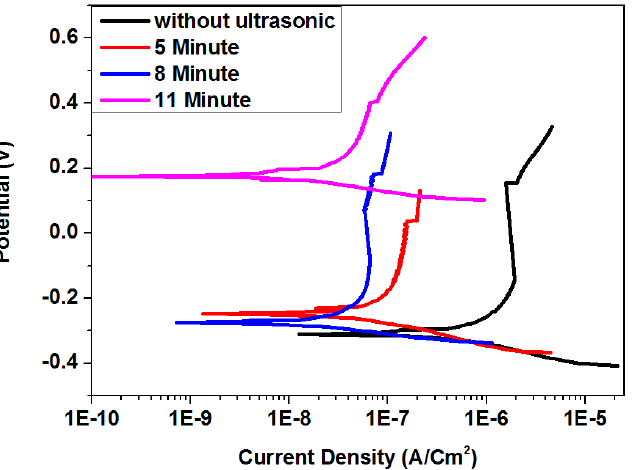
Figure 6. Tafel plots of TiN-coated samples after ultrasonic treatment at 16 kHz for 5, 8, and 11 min (extreme high PVD condition). (extreme high PVD condition). Table 2. Corrosion parameters calculated from Tafel and EIS results for ultrasonic treatment of TiN coatings at 16 kHz for different exposure